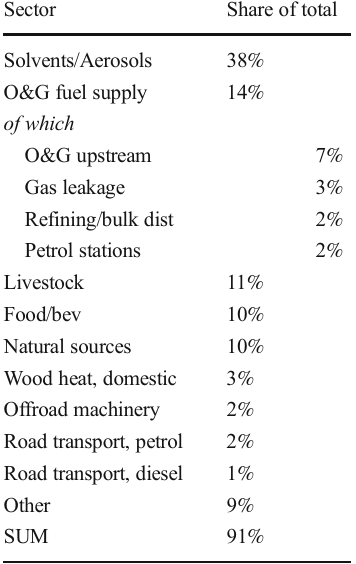
Table 2 HC emissions by sector, UK,